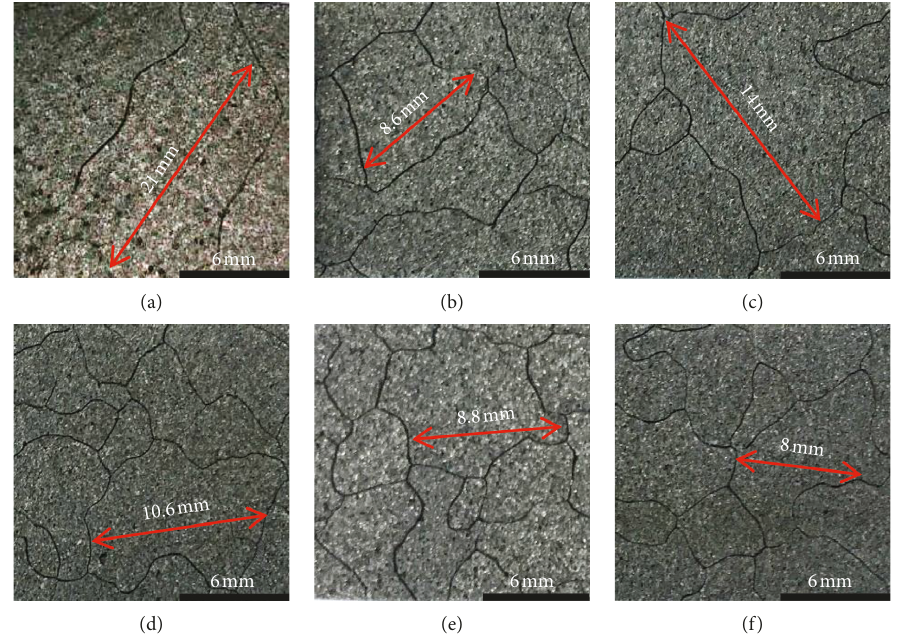
Figure 7: Microstructure of the ingots: (a) the conventional ingot at position R ; (b) the conventional ingot at position 1/2 R ; (c) the conventional ingot at position 0 R ; (d) the ultrasonic ingot at position R ; (e) the ultrasonic ingot at position 1/2 R ; (f) the ultrasonic ingot at position 0 R